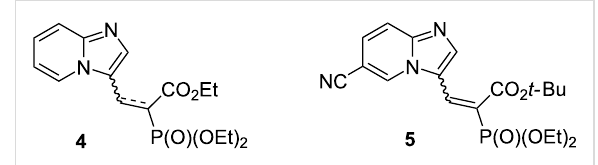
Figure 2: Structures of the identified side products 4 and 5 .